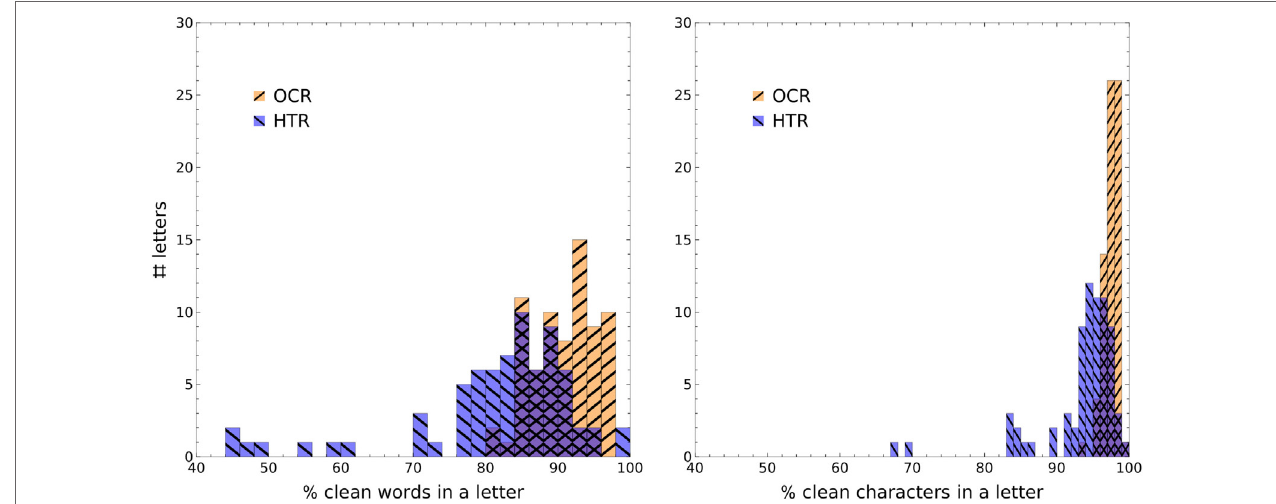
FigUre 4 | Histograms show the number of letters that have a given percentage of correctly recognized words/characters. Noticeably, HTR produces rather unstable results (the outliers to the left). For visibility, the overlap between two histograms is indicated by mixing their colors and adding a cross-pattern.